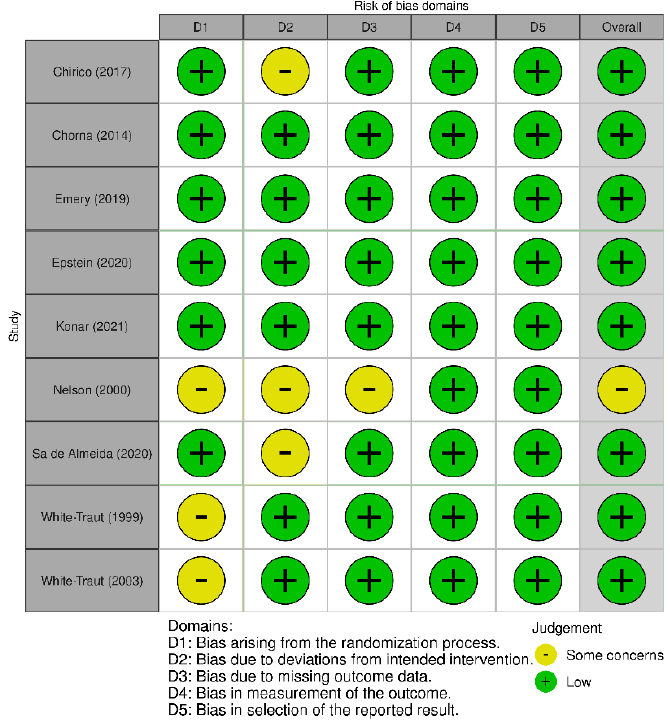
Figure A2. Risk of Bias in Randomized Trials (RoB